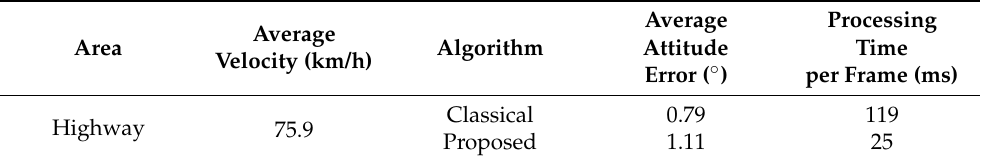
Table 2. Average attitude error and the processing time per frame of the case.